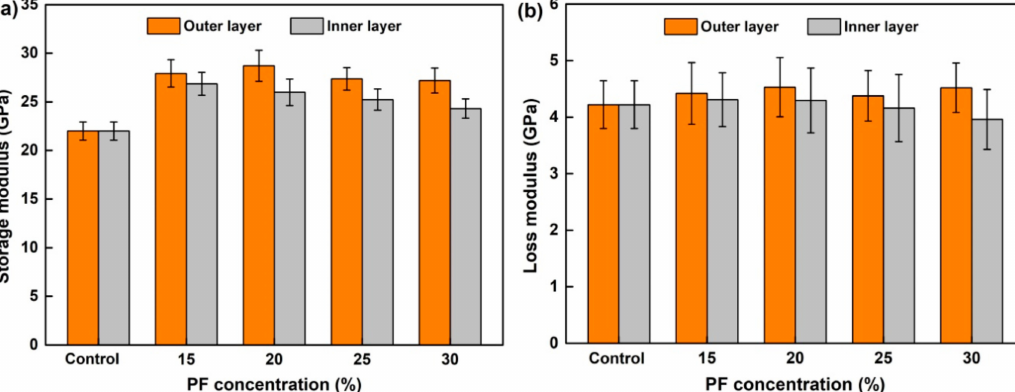
Figure11. Dynamicmechanicalpropertiesofwoodtracheids: ( a )Storagemodulusand( b